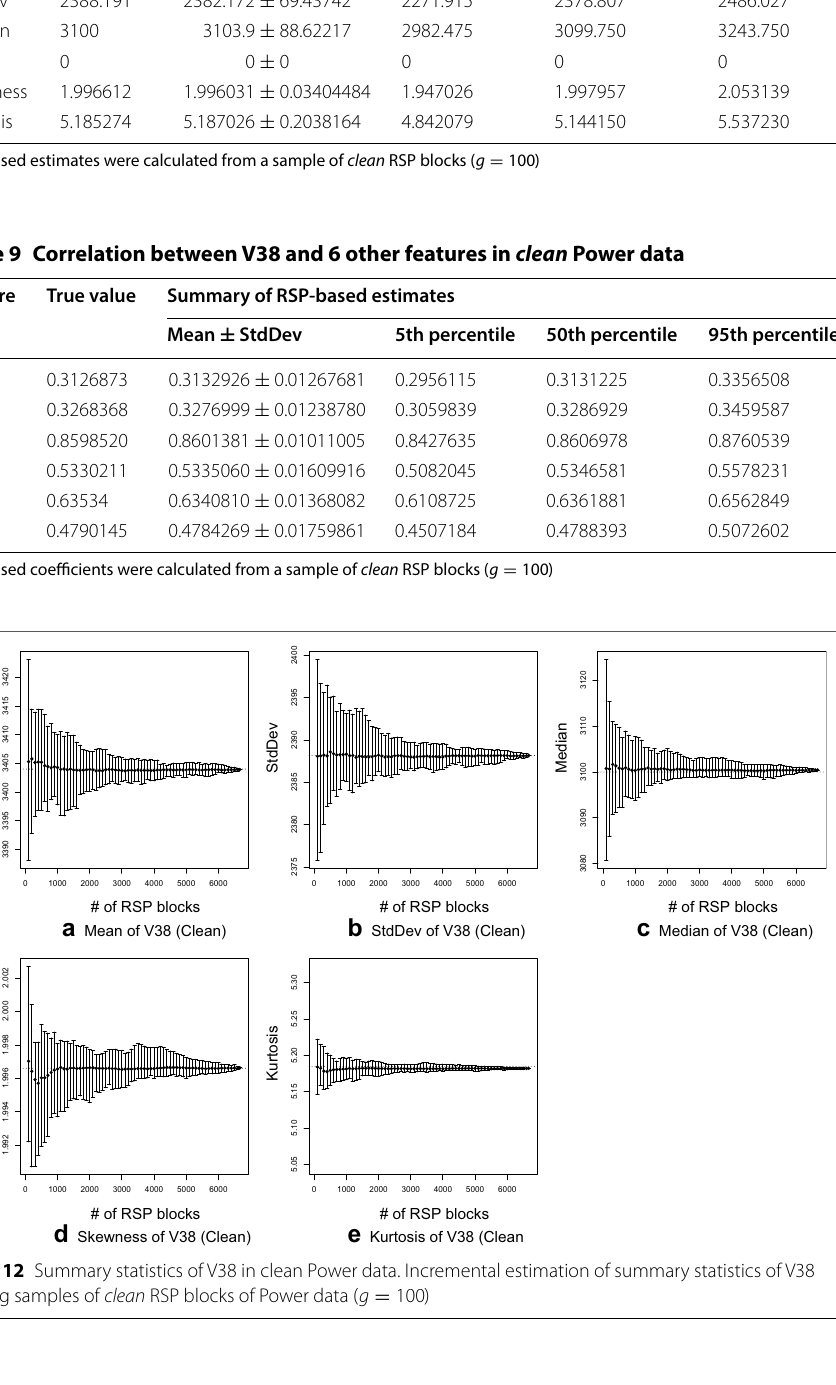
Table 8 Summary statistics of feature V38 in clean Power data